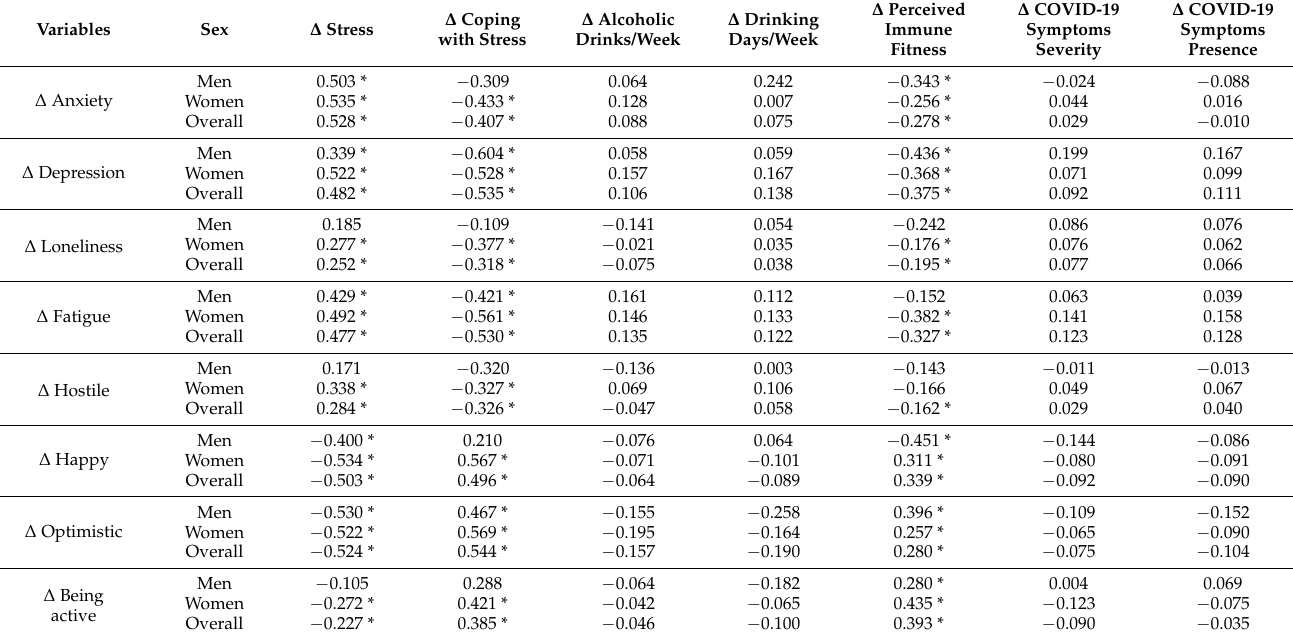
Table 5. Relationship of mood with other study outcomes.